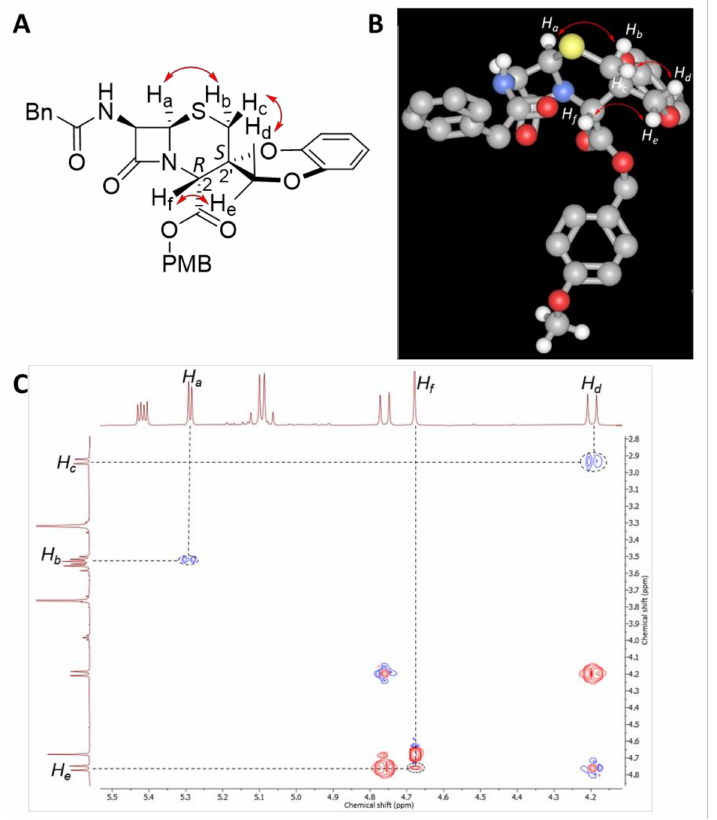
Figure 2. Structure of spiro-cephalosporin 5 in ( A ) 2-D and ( B ) 3-D; ( C ) the NOESY spectrum. To expand further the scope of the spiro-cyclisation reaction, a number of different catechols were screened under the same reaction conditions (Table